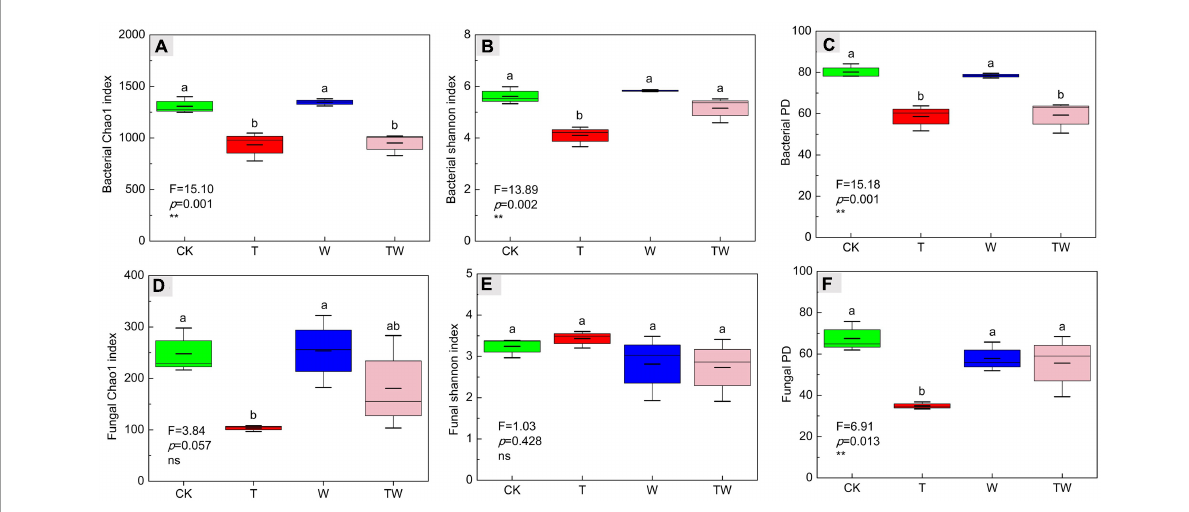
FIGURE2 Soil bacterial Chao1 richness (A) , Shannon diversity (B) , PD diversity (C) indices, and fungal Chao1 richness (D) , Shannon diversity (E) , PD diversity (F) indices affected by increasing temperature (T), increasing precipitation (W), and their interaction (TW). Values (mean ± SE) with different letters indicate significant differences at p < 0.05